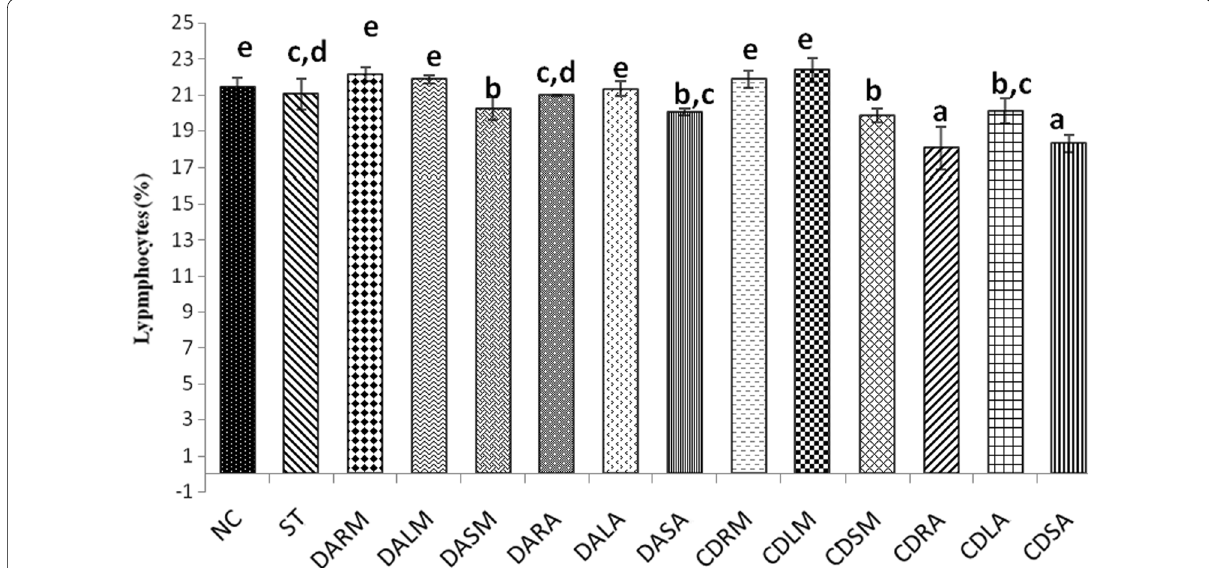
Fig. 7 Effects of methanolic and aqueous extracts of roots, leaves and stem of D. arborescens and C. dependens on Lymphocytes of albino rats. Bars with similar alphabets are not statistically different ( p < 0.05)